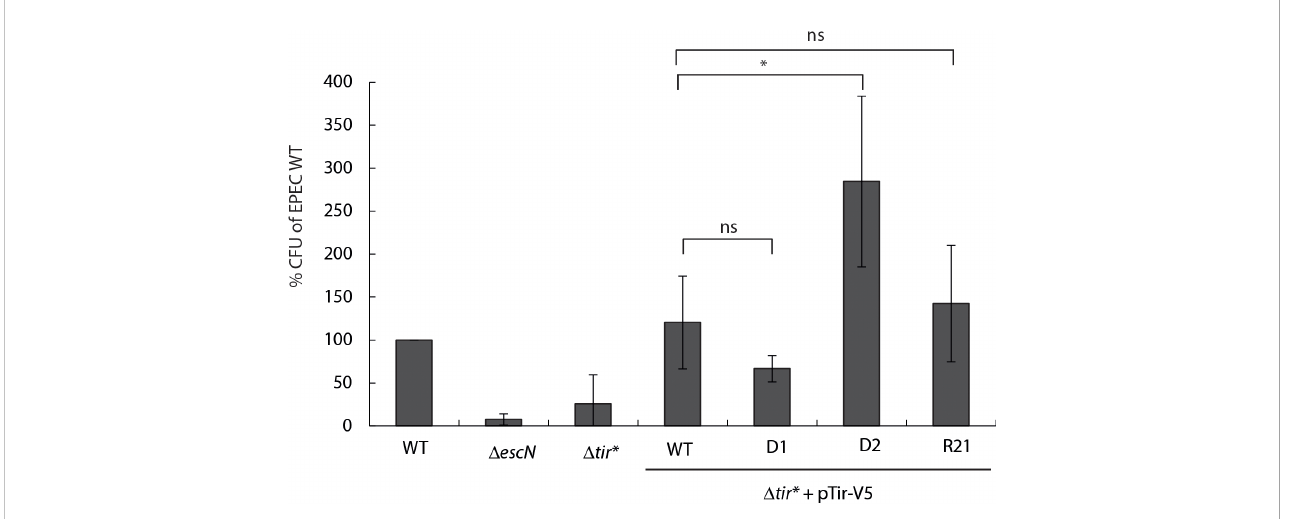
FIGURE 5 Gentamicin protection assay. HeLa cells were infected with EPEC WT, D escN , D tir *, and EPEC D tir* expressing Tir wt -V5, Tir- D1 -V5, Tir- D2 -V5, or Tir- R21 -V5 for 3 h. The cells were washed and incubated in fresh DMEM with 100 µg/mL gentamicin for 1 h. The cells were then washed and lysed with Triton X-100 (0.1% (v/v)). Samples were then plated at serial dilutions on LB plates with carbenicillin. The plates were incubated overnight at 37°C, and bacterial colony-forming units (CFUs) were then counted. The percent of bacterial colonies relative to EPEC WT is presented. Bars represent geometric means for each strain, tested in triplicate in fi ve independent experiments. Error bars represent standard deviation. *, p<0.05, unpaired Student ’ s t-test. ns, not signi fi cant.